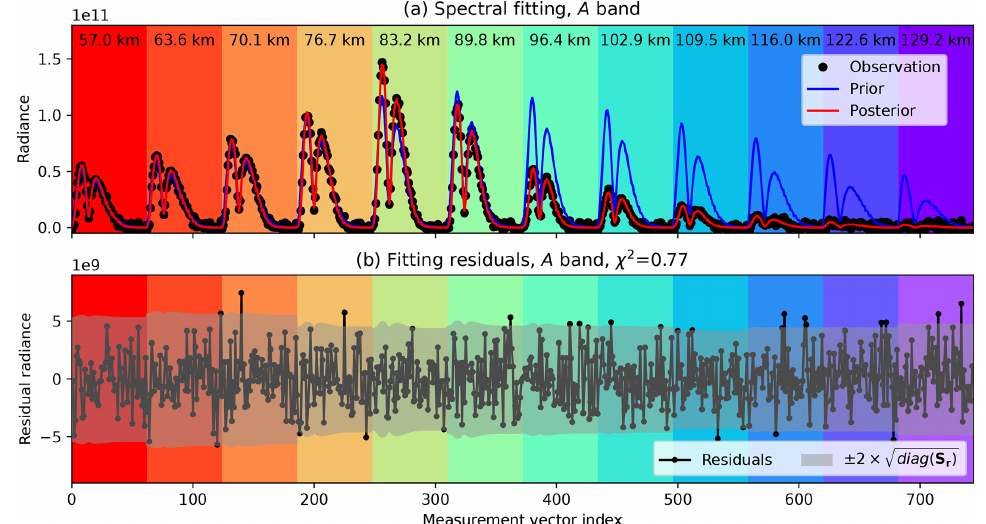
Figure 6. Similar to Fig. 4 but showing the O 2 A -band fitting using 12 limb views from the same MLT vertical sounding. Each limb-viewed A -band spectrum contains 62 data points, so the entire measurement vector has 744 elements.